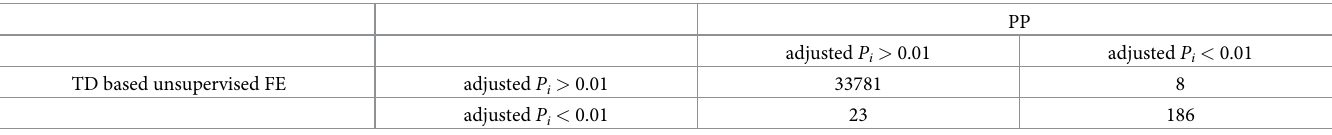
Table 3. Confusion matrix of selected mRNAs between TD-based unsupervised FE and PP in the second data set. P -value computed by Fisher’s exact test is 0.0 within numerical accuracy (i.e., smaller than the possible smallest number given numerical